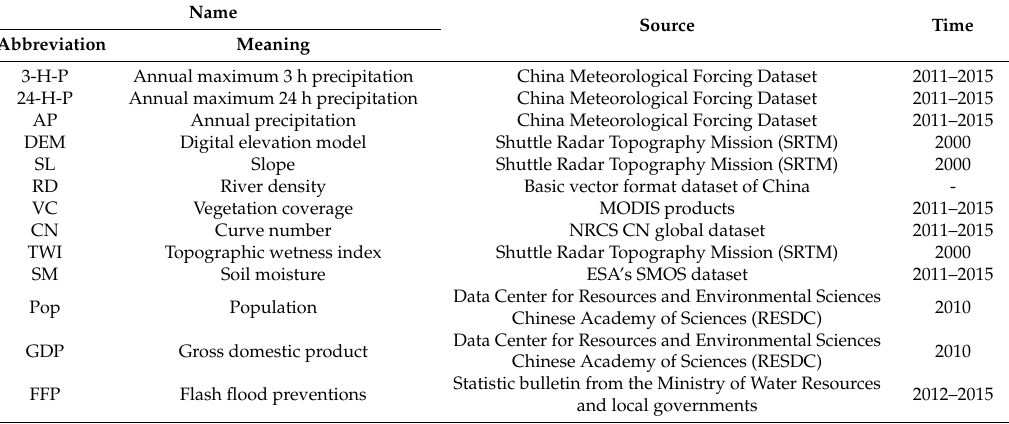
Table 1. Factors, flood inventories and data sources.